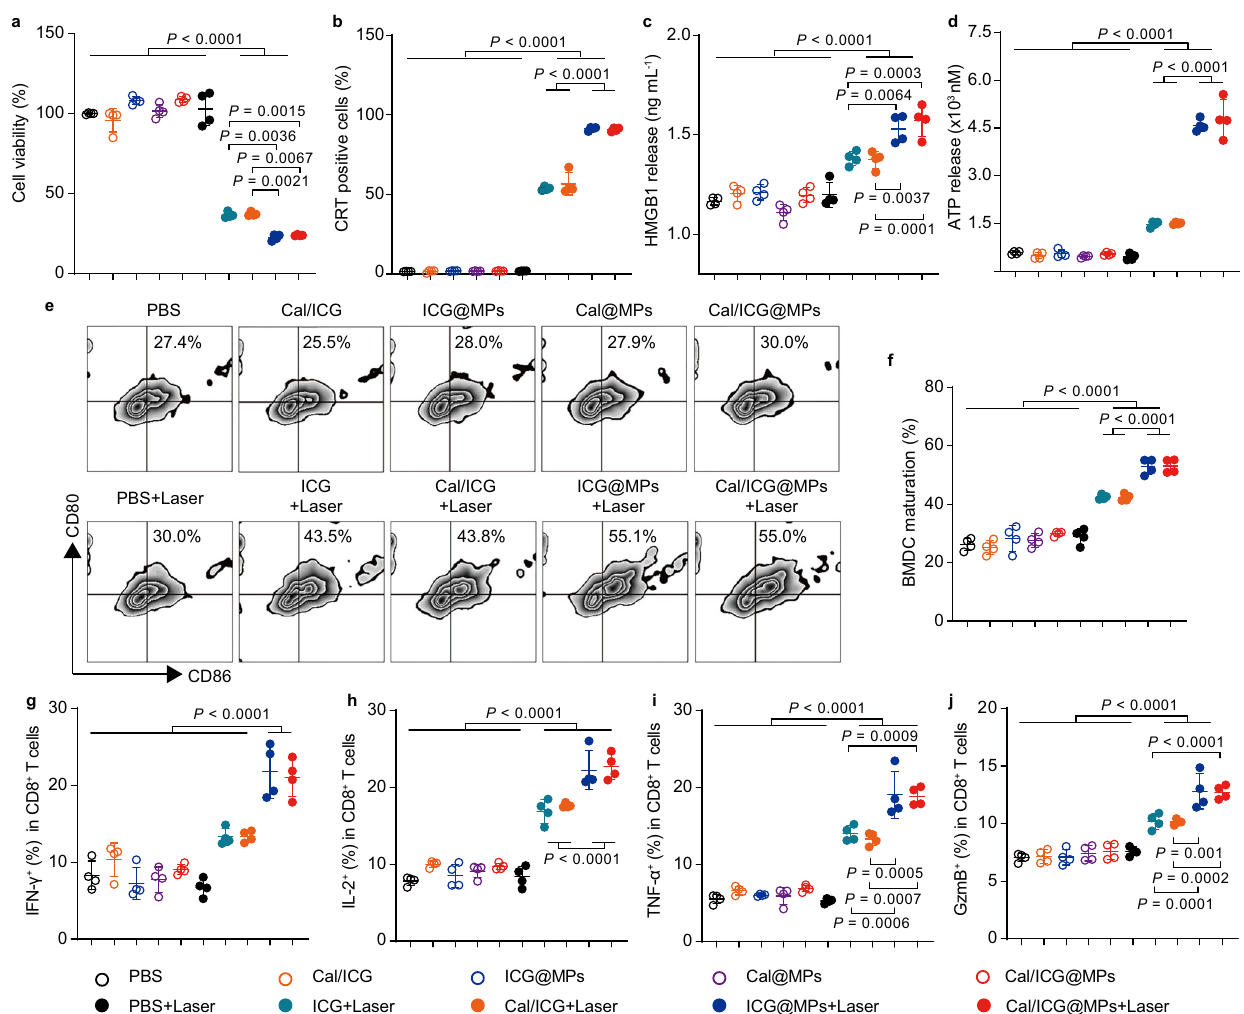
Fig. 3 In vitro ICD effects, DC maturation, and T-cell activation triggered by Cal/ICG@MPs upon 808nm laser irradiation. a Cell viability of H22 cells after treatment with PBS, ICG, Cal/ICG, ICG@MPs, Cal@MPs, or Cal/ICG@MPs derived from H22 cells at the ICG concentration of 4 μ g mL − 1 and Cal concentration of 60 ng mL − 1 for 4 h in the presence or absence of 808 nm laser irradiation (1 W cm − 2 , 5 min). Data are presented as means ± s.d. ( n = 4 biologically independent samples; one-way ANOVA followed by Tukey ’ s HSD post hoc test). b CRT exposure on the above treated H22 cells by fl ow cytometry. Data are presented as means ± s.d. ( n = 4 biologically independent samples; one-way ANOVA followed by Tukey ’ s HSD post hoc test). c , d HMGB1 extracellular release ( c ) and ATP extracellular secretion ( d ) from the above treated H22 cells by using the HMGB1 ELISA kit and chemiluminescence ATP determination kit, respectively. Data are presented as means ± s.d. ( n = 4 biologically independent samples; one-way